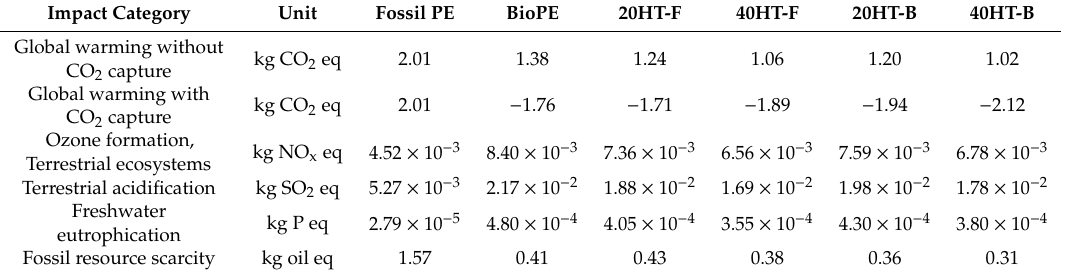
Table 4. Environmental burdens per impact category for evaluated materials *.